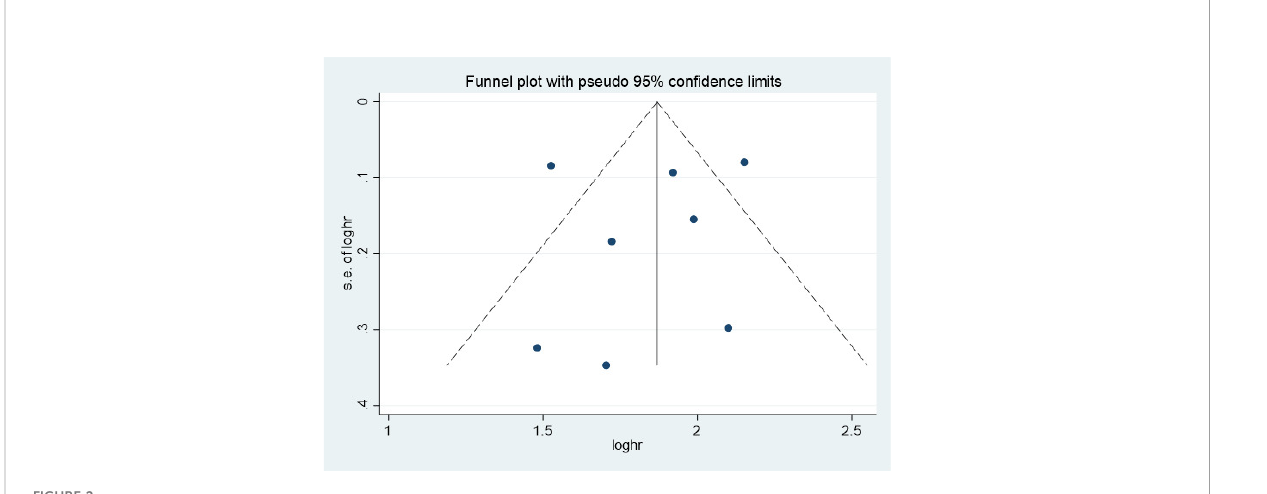
FIGURE 2 The funnel plot of the risk of bias. SE, standard error.